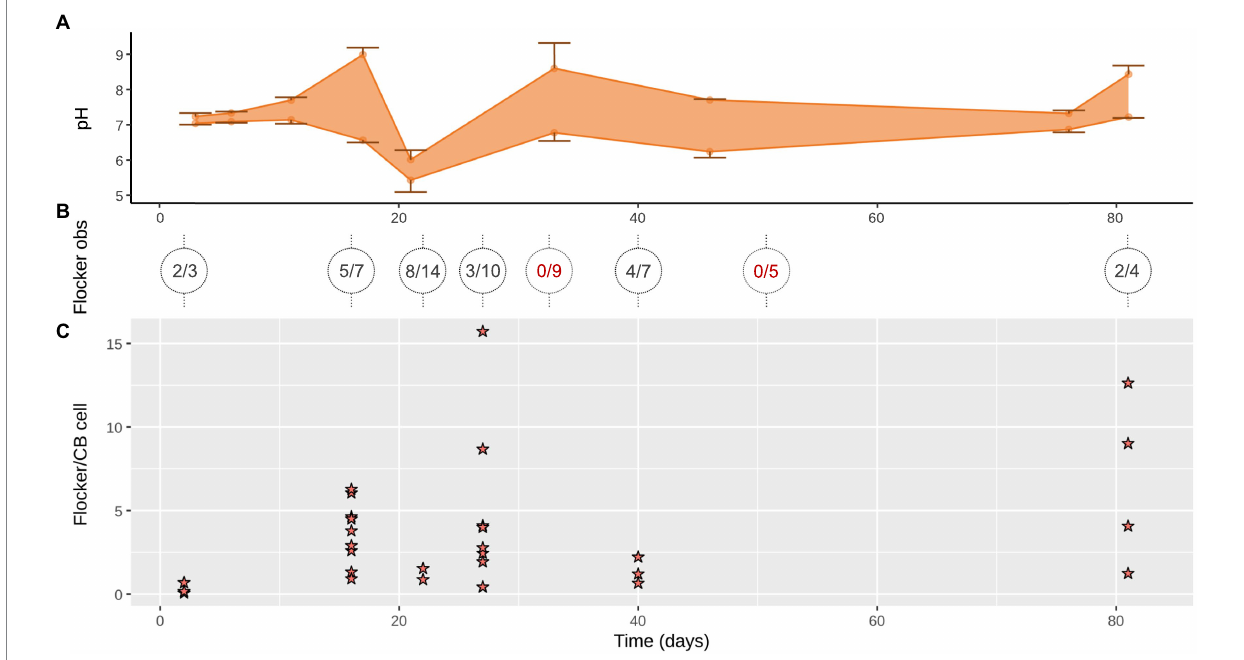
FIGURE 2 (A) Range of pH minima and maxima in the anoxic zone (down to 13 mm) where cable bacteria and flockers were observed (mean ± SD, n = 2–4). (B) Flocking observed over 1–4 days (on trench slides during TS2) in x/y where x is number of trench slides with successful flocking observations with y as total observation attempts, circles show individual time points with lines indicating the time points the sediment originated from; red, no detected flocking. (C) Flocking was often observed in multiple instances on a single trench slide, each instance is represented by a star. Each star indicates the